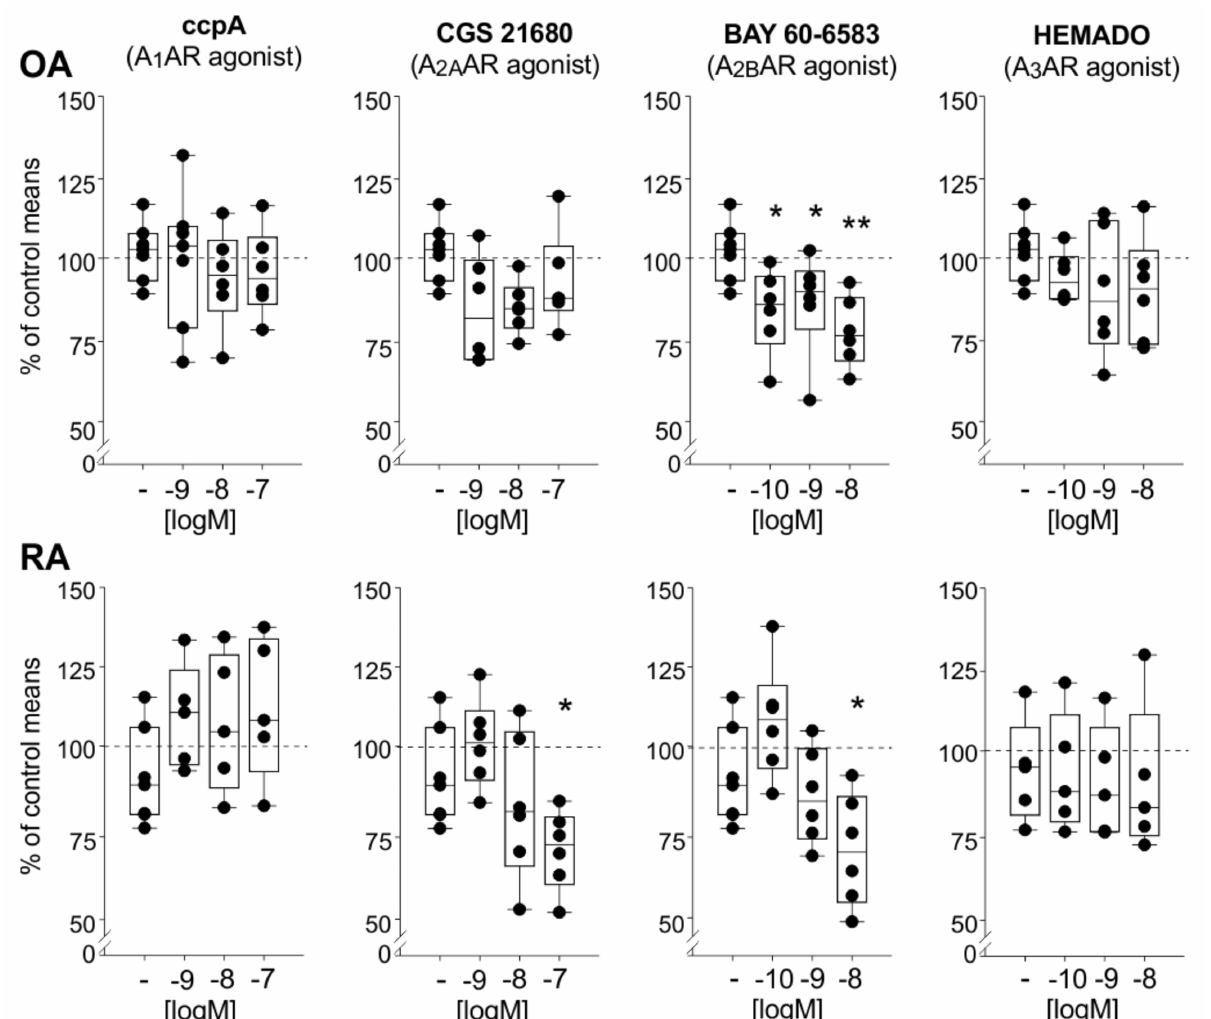
Figure 5. IL-6 release in OA and RA mixed synoviocyte cultures after activation of individual adenosine receptor subtypes by applying different AR agonists. Data are represented as box plots (as explained in the legend of Figure 1) ( n = 5–6). Values are expressed as percent of untreated control (untreated control is represented as “-“; the mean of untreated controls is represented as dashed line = 100%). Significant p -values compared to untreated control are presented as * p ≤ 0.05 ** p ≤ 0.01 when compared to untreated controls. Abbreviations: see legend to Figure